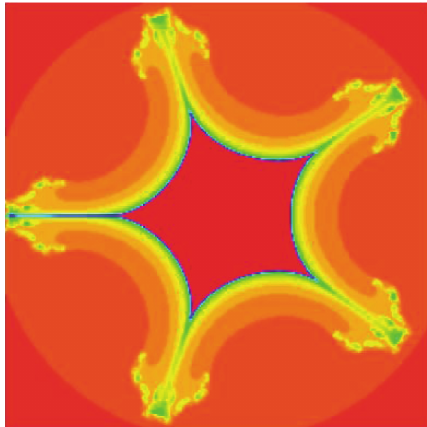
Figure 20: Relative superior multicorn for 𝑠 = 0.3 , 𝑠 󸀠 = 0.4 , and 𝑛 = 7 .